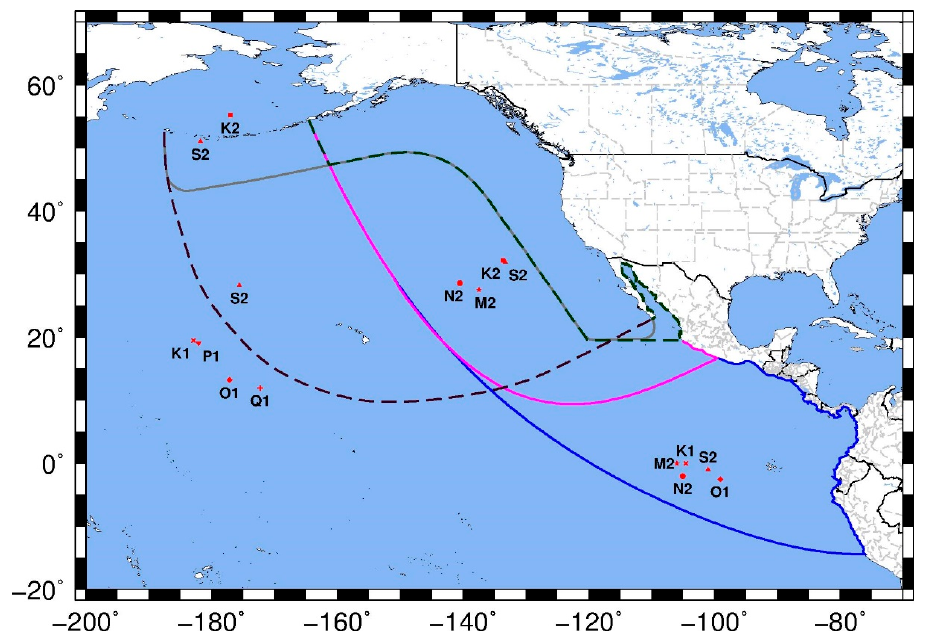
Figure 2. Location of amphidromic points relative to the ESTOFS-Pacific (dashed purple), ENPAC1994 (blue), ENPAC02 (magenta), ENPAC03 (dashed dark green) and ENPAC15 (gray) model domains.